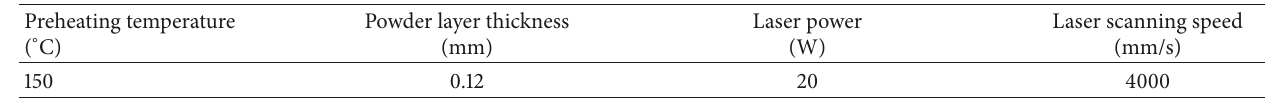
Table 3: Technological parameter during SLS.